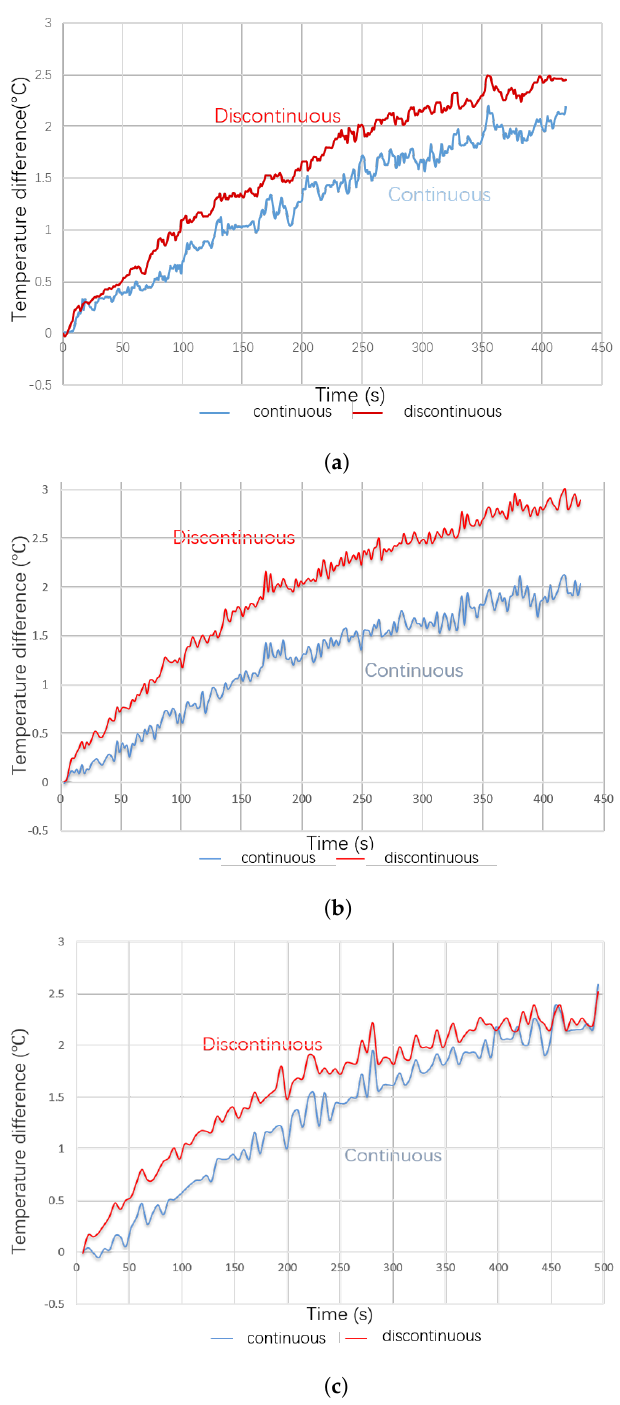
Figure 13. Sweeping—period influence on the temperature difference of two cooling systems. ( a ) 0.2 s pulsation period; ( b ) 1 s pulsation period; ( c ) 5 s pulsation